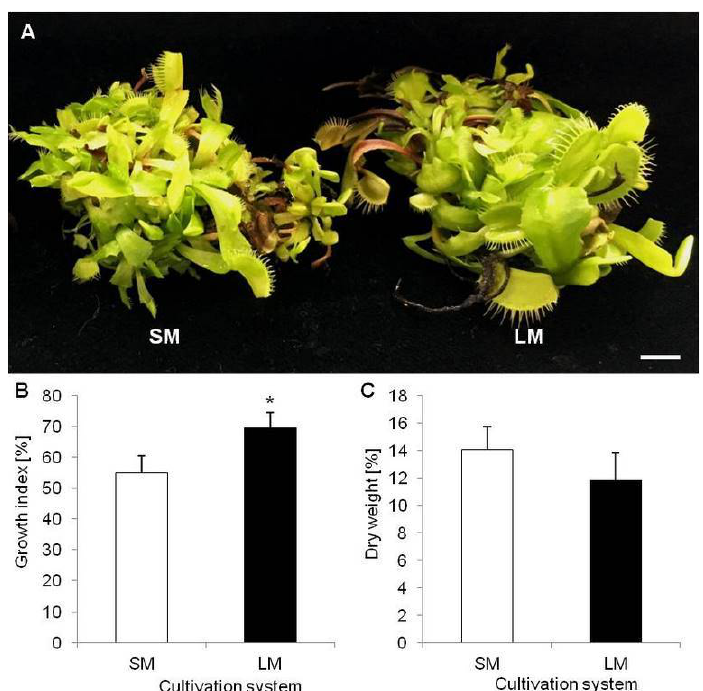
Figure 1. Dionaea muscipula plants in different cultivation systems: ( A ) plants cultivated on solid medium (SM) and in liquid medium with rotary shaking (LM); ( B ) growth index [%] of plants depending on cultivation system; ( C ) dry weight content [%] of plants depending on cultivation system; * significant difference between means at p < 0.05; bar—1 cm.